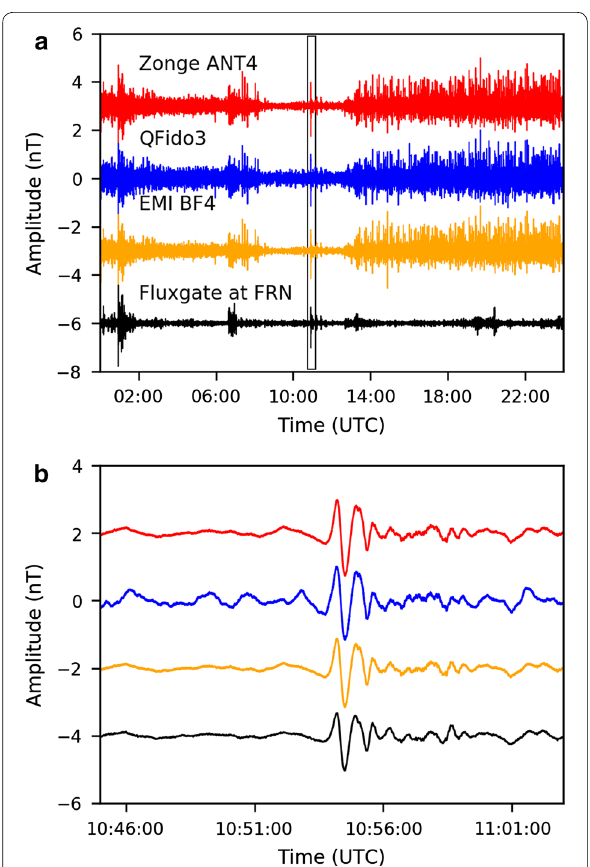
Fig. 9 a Same time series as Fig. 8b but with a 200-s high-pass filter, and with the addition of the FRN fluxgate-magnetometer time series. b Expanded view of gray box in a , ~ 20 min of data, showing what we interpret as a Pi2 irregular geomagnetic pulsation spanning ~ 3